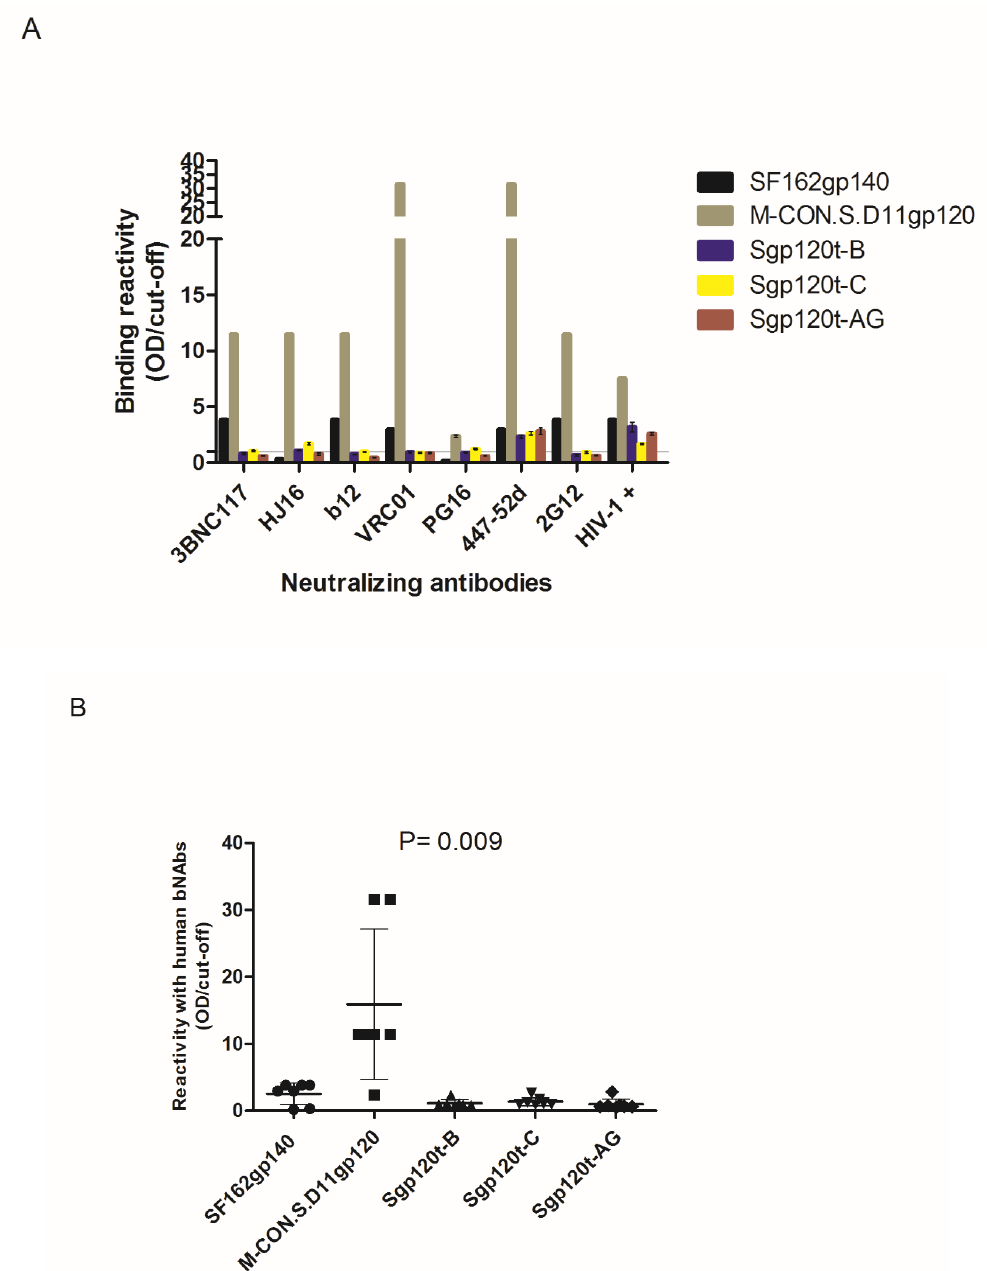
Figure 2. Binding reactivity of human monoclonal antibodies against soluble truncated gp120 glycoproteins and reference glycoproteins. ( A ) Bar graphic showing the antibody reactivity (mean and standard deviation) of the different envelope gp120s against each human monoclonal antibodies and serum from HIV-1 infected individual; ( B ) Dot-plot graphic comparing the mean reactivity of each envelope glycoprotein against all monoclonal antibodies. Error bars are standard deviation. One-way ANOVA test with Dunn's Multiple Comparison Test was used to compare the reactivity of the different monoclonal antibodies against the envelope glycoproteins. Amino acid sequences of the new envelope glycoproteins were inspected to try to explain their antigenic profile. The most divergent regions regarding sequence and number of amino acids were